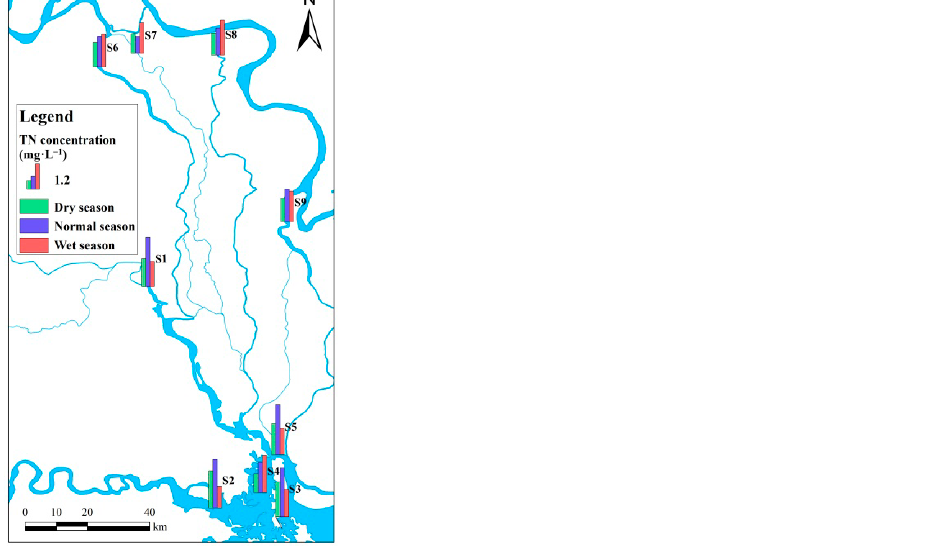
Figure 5. Spatiotemporal distribution of TN concentration in three periods. In the legend, the length of the red bar represents the unit length, whose value is 1.2 mg · L − 1 .